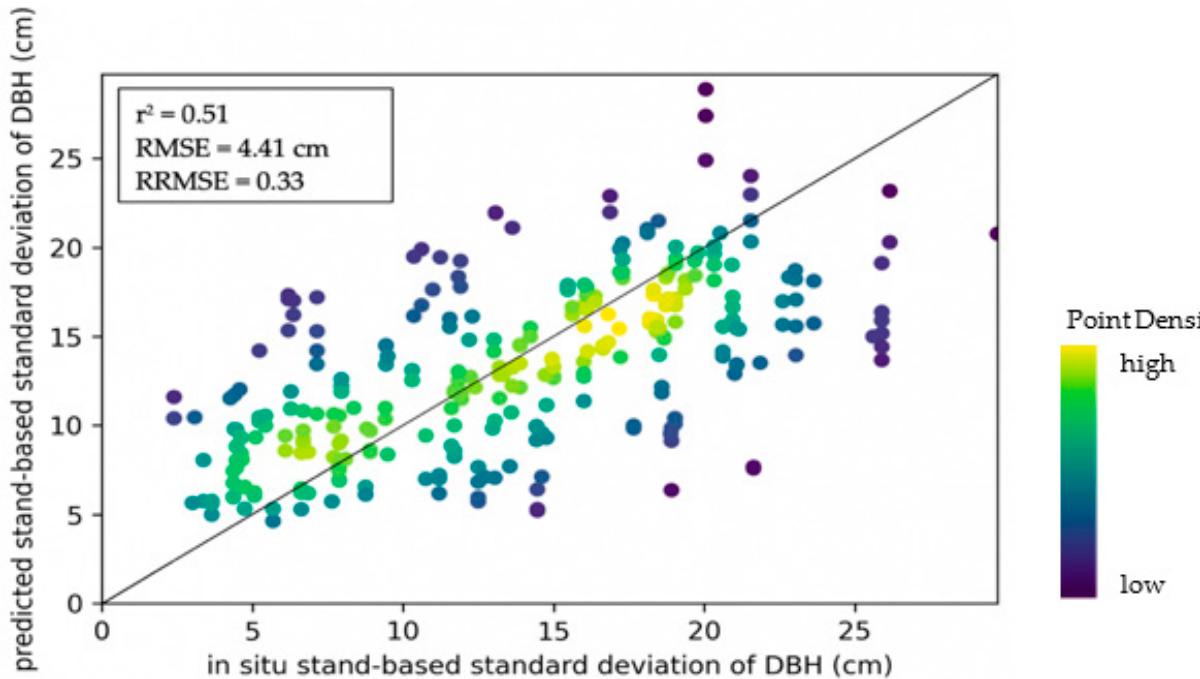
Figure 9. Density scatterplot showing the relationship between predictions of structural diverstiy (standard deviation of DBH) and in situ values for 150 plots based on the model with sixteen Sentinel-1 features.